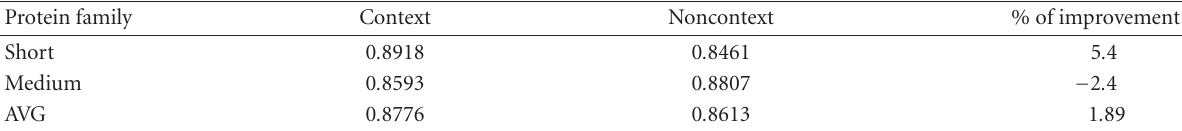
Table 5. The influence of orphans on the quality of the alignment.